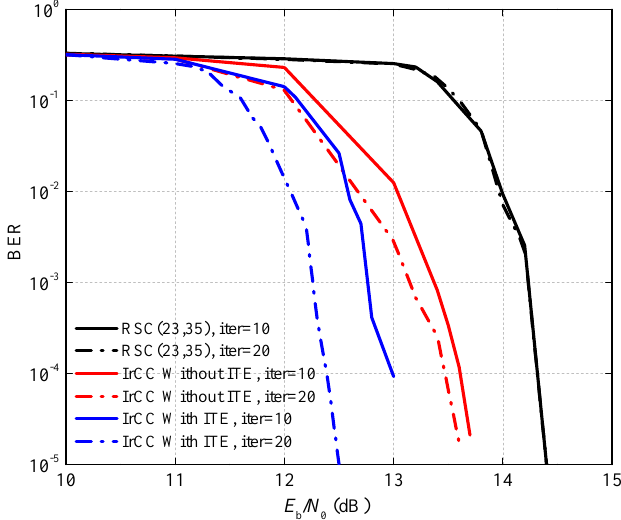
Figure 7. BER performance comparison of three encoding and decoding schemes under different iteration times, R = 0.5, k =